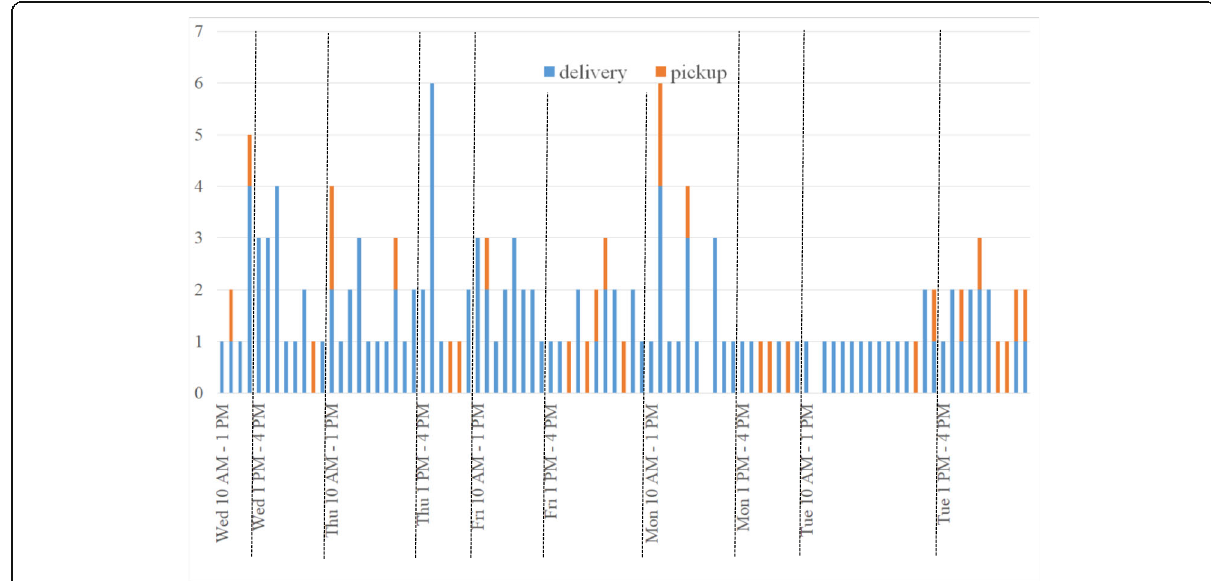
Fig. 6 Number of delivery and pickup episodes for each recorded